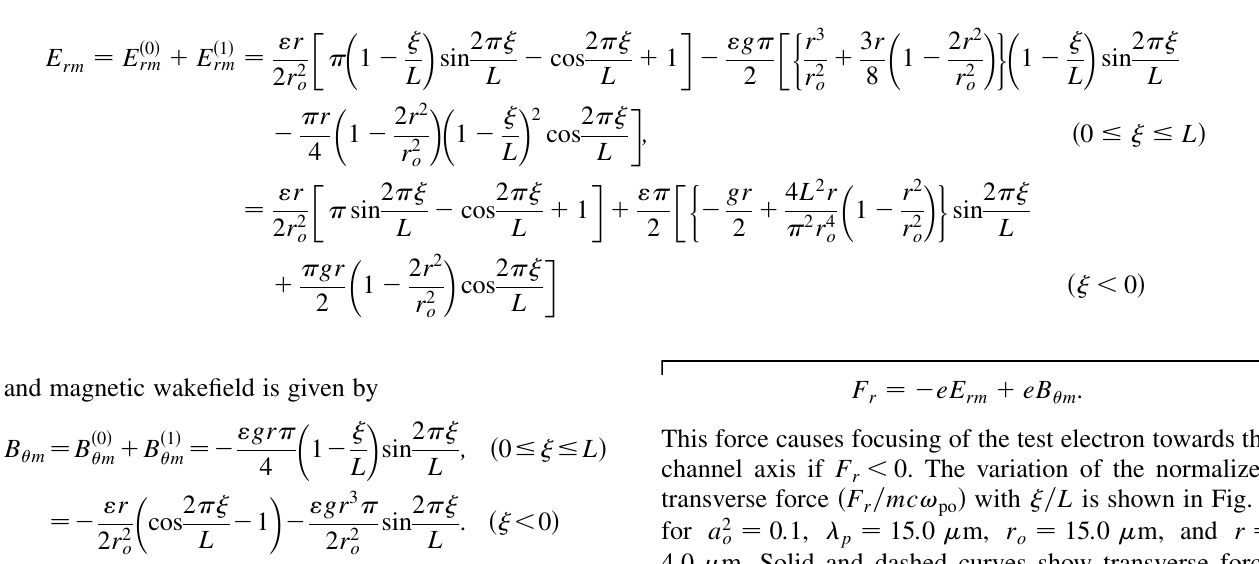
(cid:4) generated by a matched laser pulse, as a function of r (in & m ) in plasma channel (solid =mc! z po (cid:2) 0 : 1 , $ (cid:2) 15 : 0 & m , r (cid:2) 15 : 0 & m , and (cid:29)=L (cid:2) (cid:5) 1 : 0 p o o